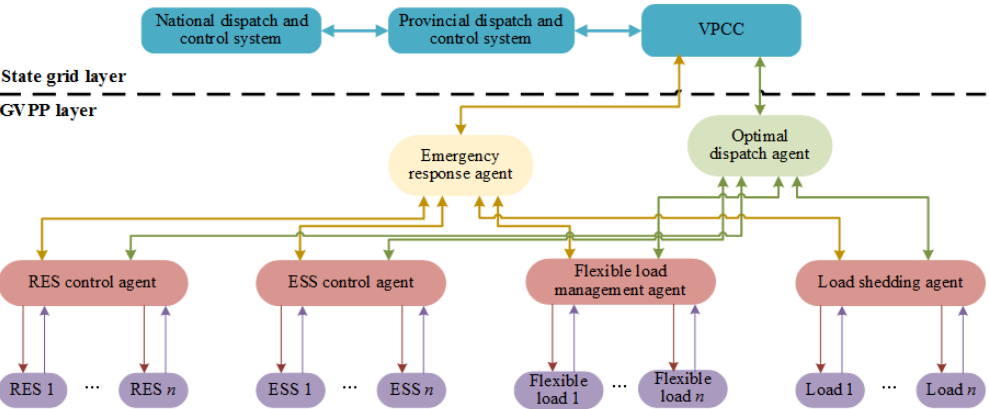
Figure 7. Multi-agent architecture of a GVPP.